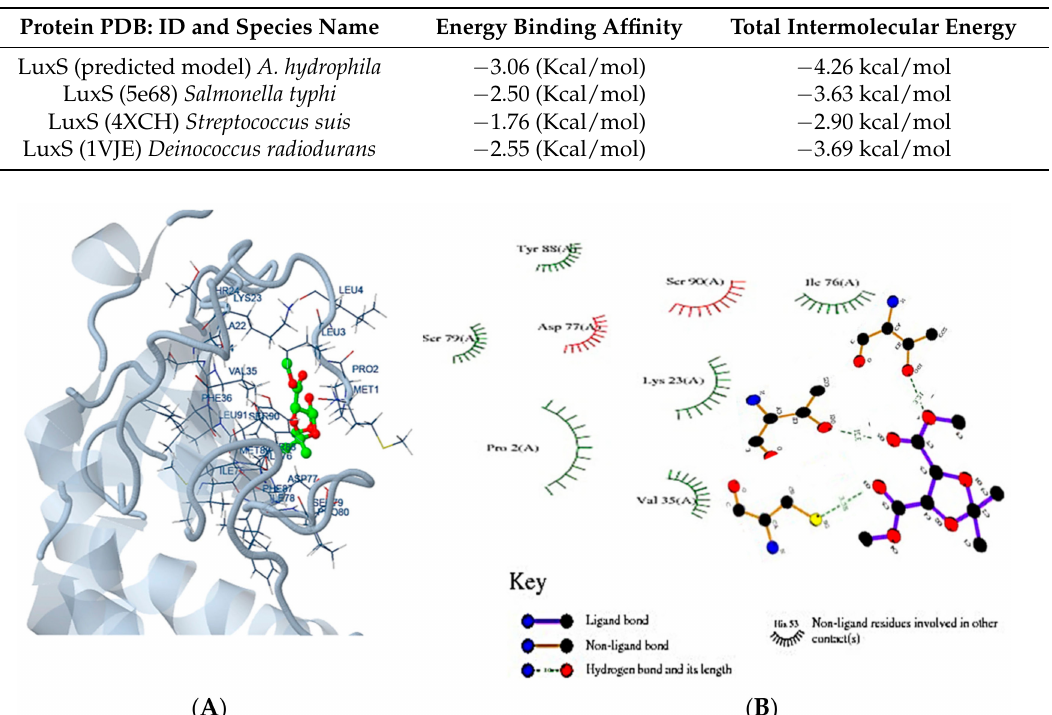
Table 4. The calculation of energy binding affinity and intermolecular energy of LuxS proteins with ligand by docking server.